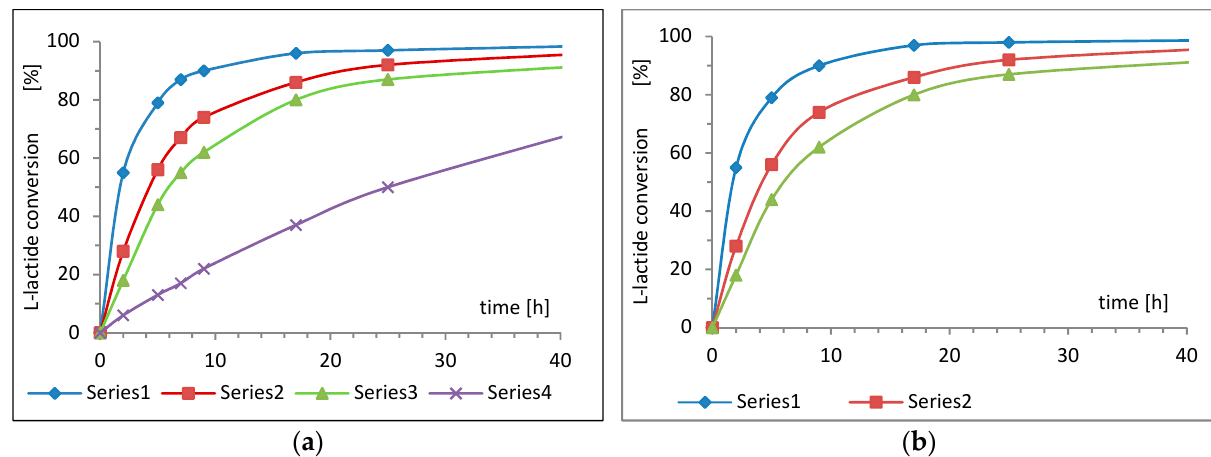
Figure 7. The dependence of lactide conversion and time of the conducted polymerization in bulk at 120 °C, initiated by ( a ) Zn[(acac)(LPhe)H 2 O], and ( b ) Zn[(acac)(LTrp)H 2 O]. Series 1—with an M/I ratio of 150:1; Series 2—with an M/I ratio of 400:1; Series 3—with an M/I ratio of 600:1; Series 4—Zn[(acac)H 2 O] with an M/I ratio of 600:1.